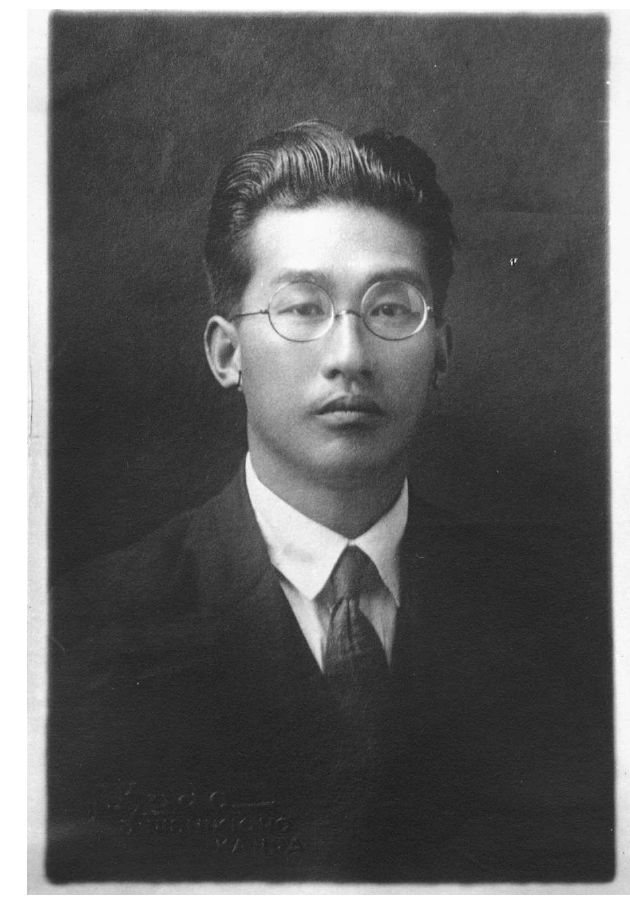
Figure 7. Syuichi Imamichi, the first director of Kakioka Magnetic Observatory, in 1927. He led the observatory for about 28 years from 1923 to 1952 (photo supplied by Kakioka Magnetic Observa-